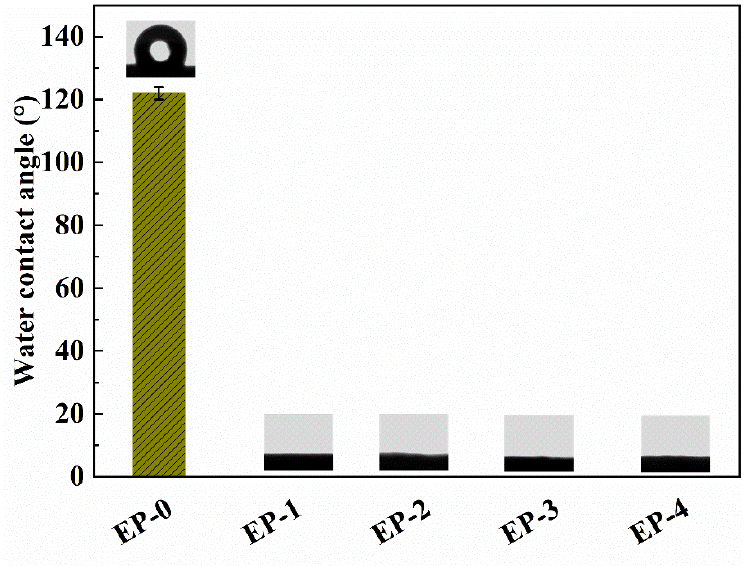
Figure 5. The water contact angles of EVOH/PANI composite NFAs before and after chemical vapor deposition.